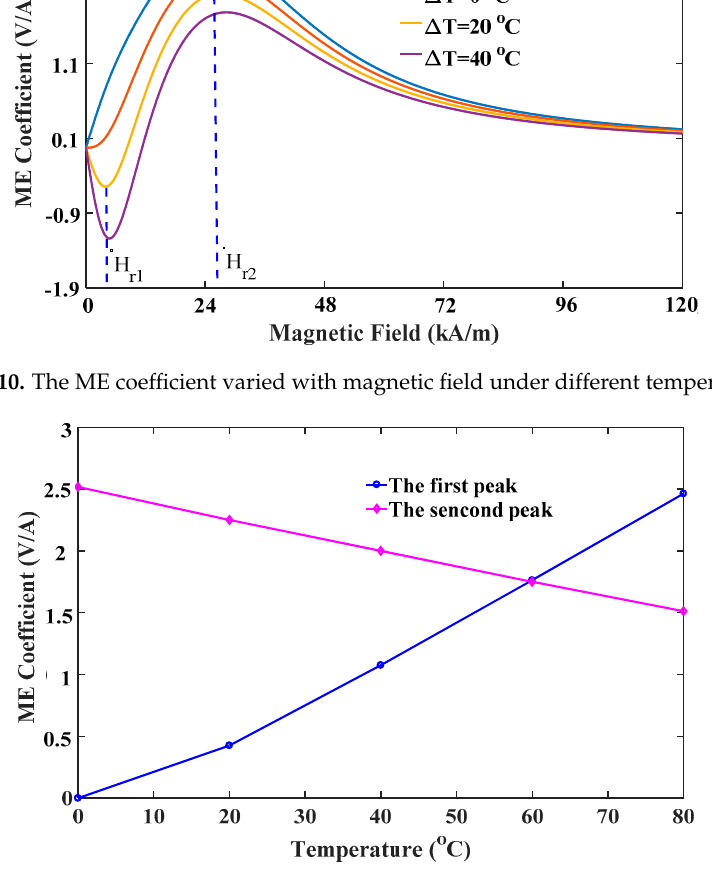
Figure 11. The peak values of the ME coefficient varied with temperature.